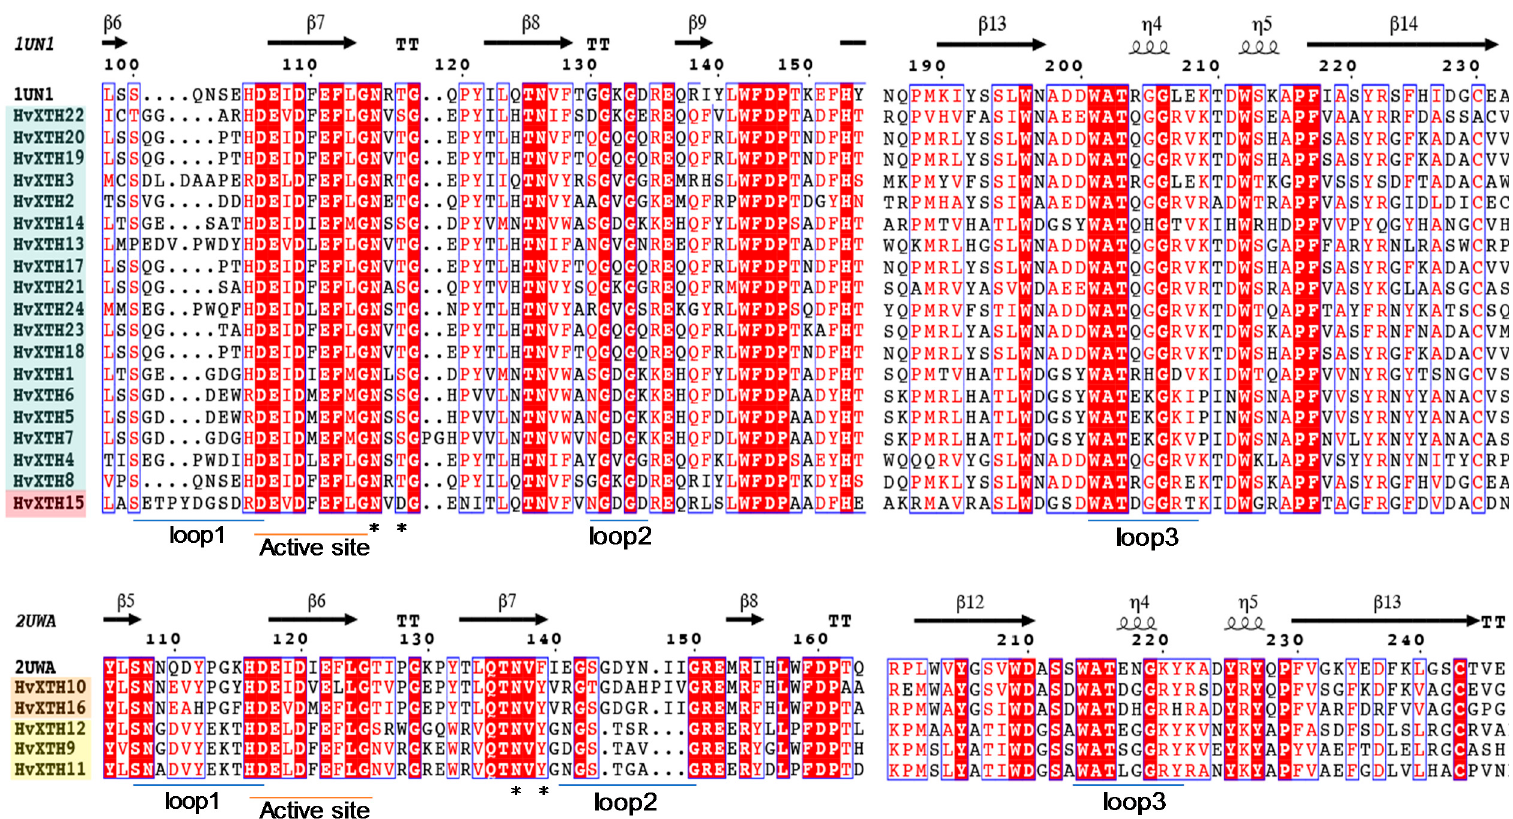
Figure 4. Structure-based sequence alignment of HvXTHs. Sequence were aligned using MEGA7 and secondary structures predicted using ESPript. HvXTHs in group I/II and group III had similar structures to PttXET16-34 (1UN1) and TmNXG1 (2UWA), respectively, whose structures have been experimentally determined. Group I/II HvXTHs are in light blue, group III/A in orange, group III/B in yellow, the ancestral group in red. Blue frames indicate conserved residues, white letters in red boxes indicate strict identity and red letters in white boxes indicate similarity. The secondary structures of β sheets (arrows) and α -helices (spiral) and loops 1, 2 and 3 (lines) are indicated. N-glycosylation residues are indicated as asterisks. The entire alignment is presented in Supplementary Files 5 and 6.